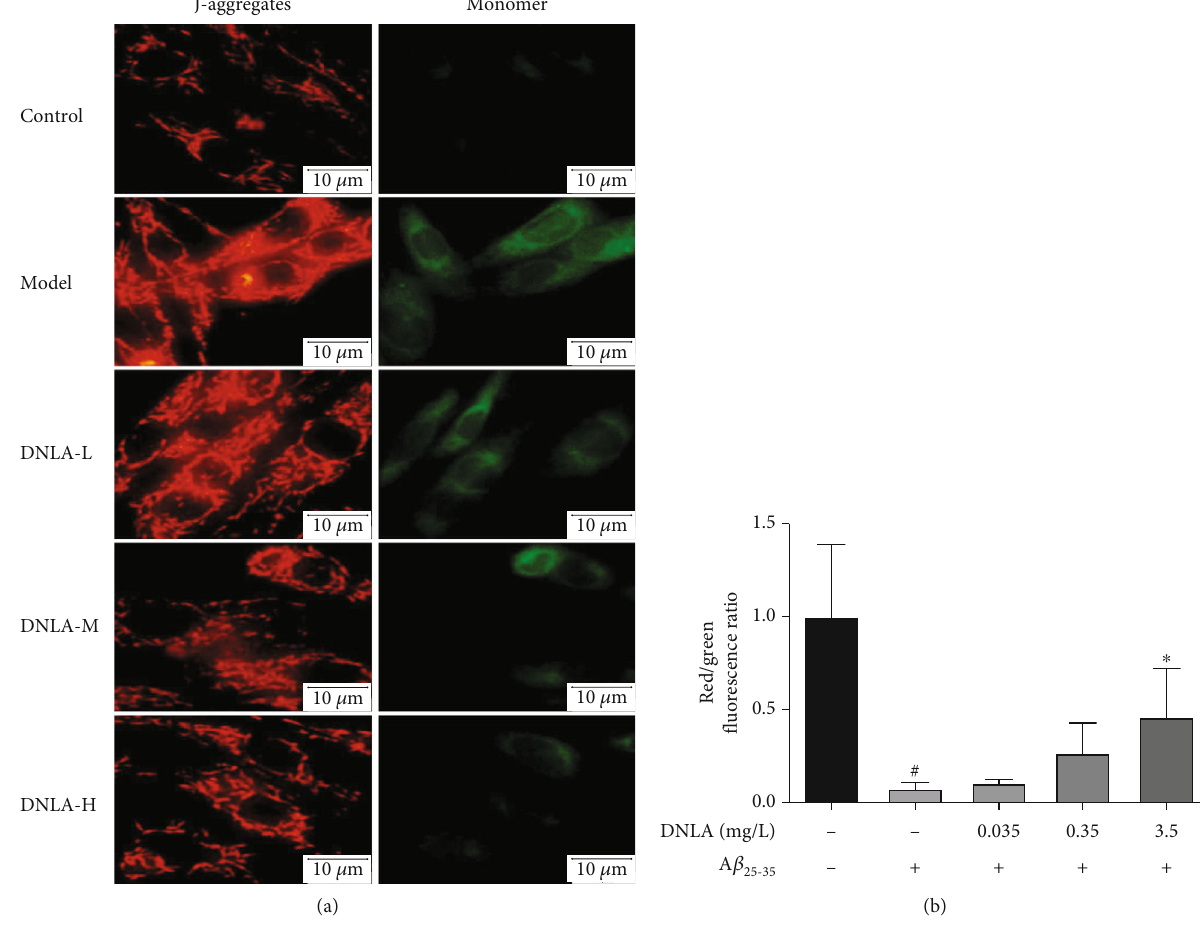
Figure 7: E ff ect of DNLA on MMP induced by A β in PC12 cells. (a) showed the respective photomicro in PC12 cells. (b) The ratio of 25-35 red/green fl uorescence in PC12 cells ( n = 5 , (cid:1) x ± s ). Note: # P < 0 : 05 vs. control; ∗ P < 0 : 05 vs.